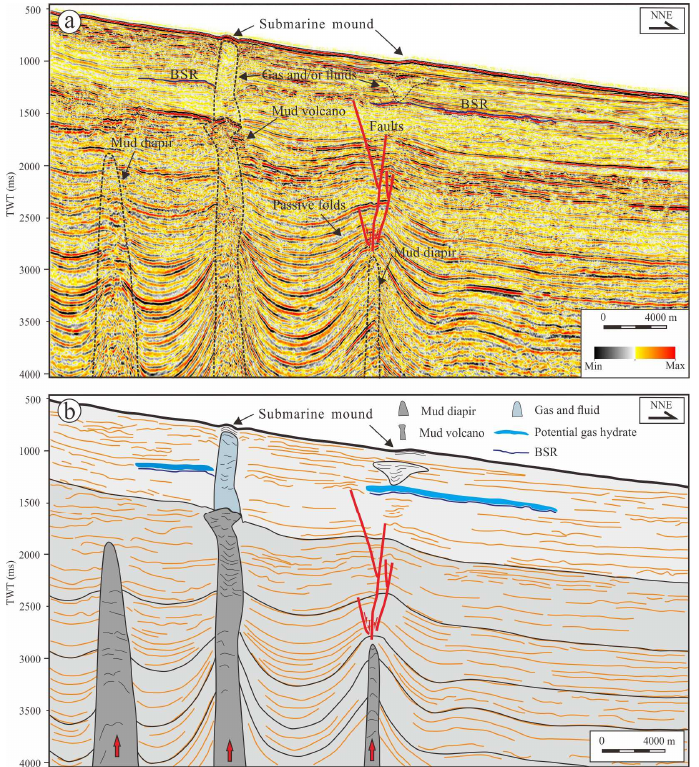
Figure 2. Seismic profile ( a ) and geological interpretation ( b ) showing the submarine mound with several mud diapirs in the northern part of the Zengmu Basin at the continental margin of the southern South China Sea. A certain scale of gas and/or fluids with potential gas hydrates near BSRs marked by the deep blue lines below the submarine mound. The location of Figure 2 correspond to the red line A in Figure 1.